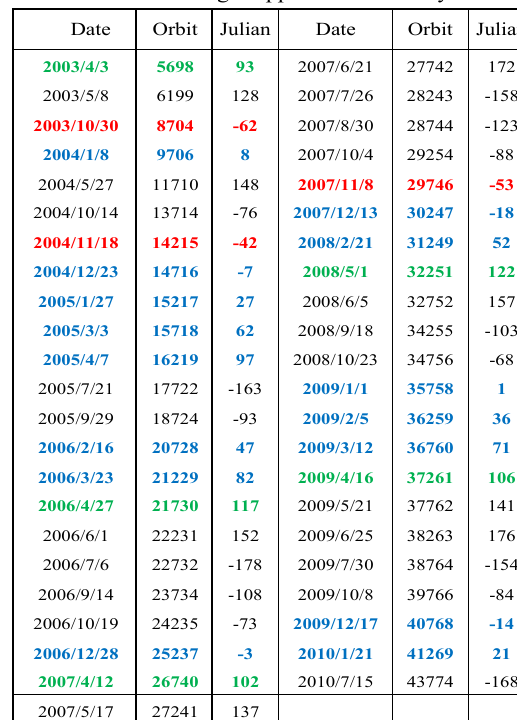
Table 1 SAR images applied in this study